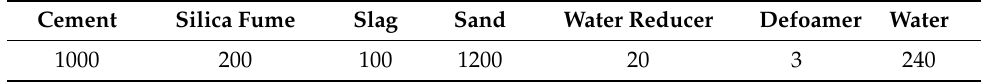
Table 3. Mixing ratio of basic matrix (kg/m 3 ).